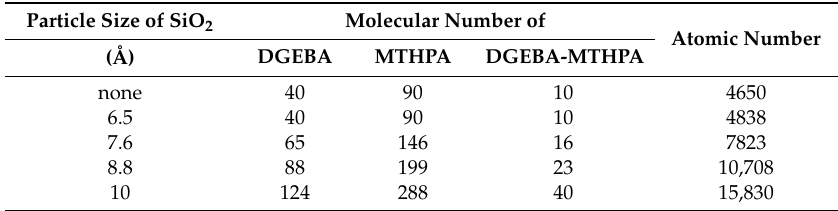
Figure 2. Molecular models. ( a ) Diglycidyl Ether of Bisphenol A resin (DGEBA); ( b ) Methyltetrahydrophthalic Anhydride (MTHPA); ( c ) DGEBA-MTHPA; ( d ) SiO 2 . Table 1. Initial components of the molecular model of each system.